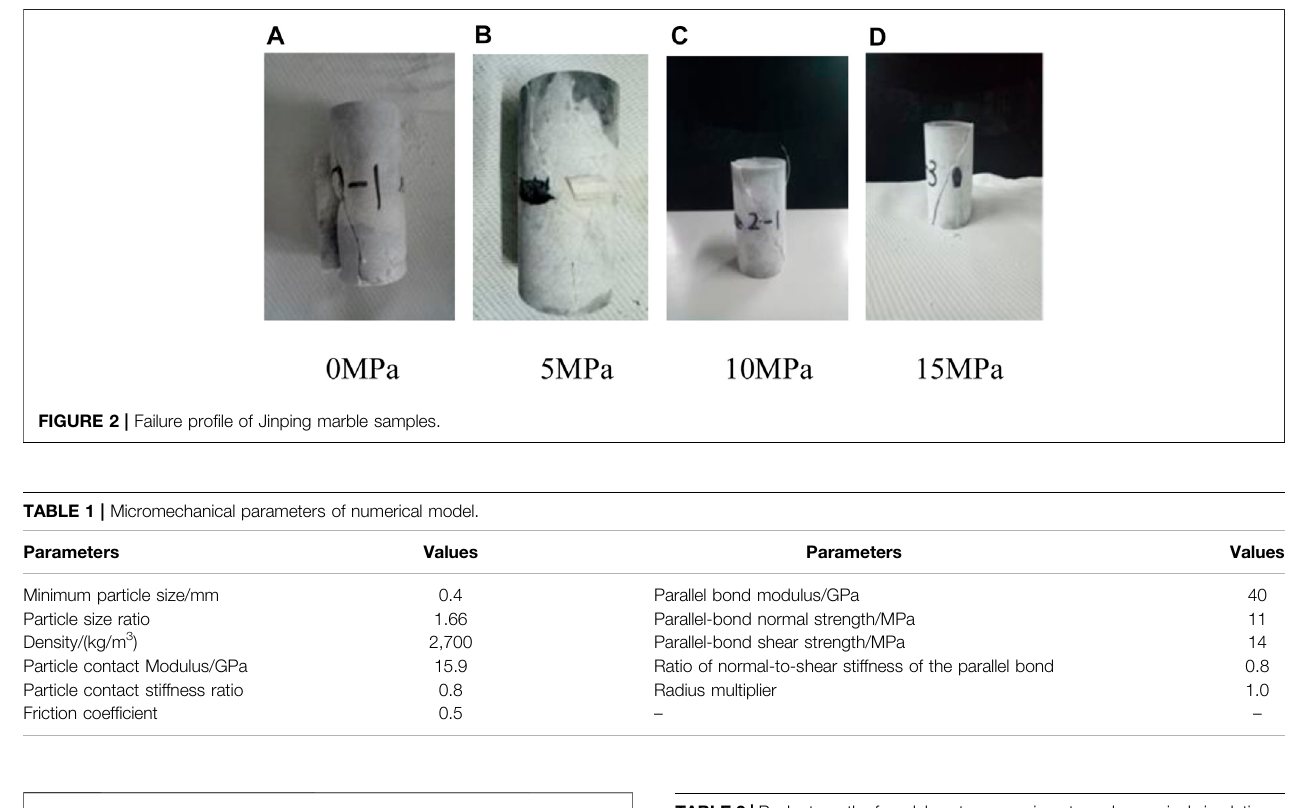
TABLE 2 | Peak strengths from laboratory experiments and numerical simulation under different con fi ning